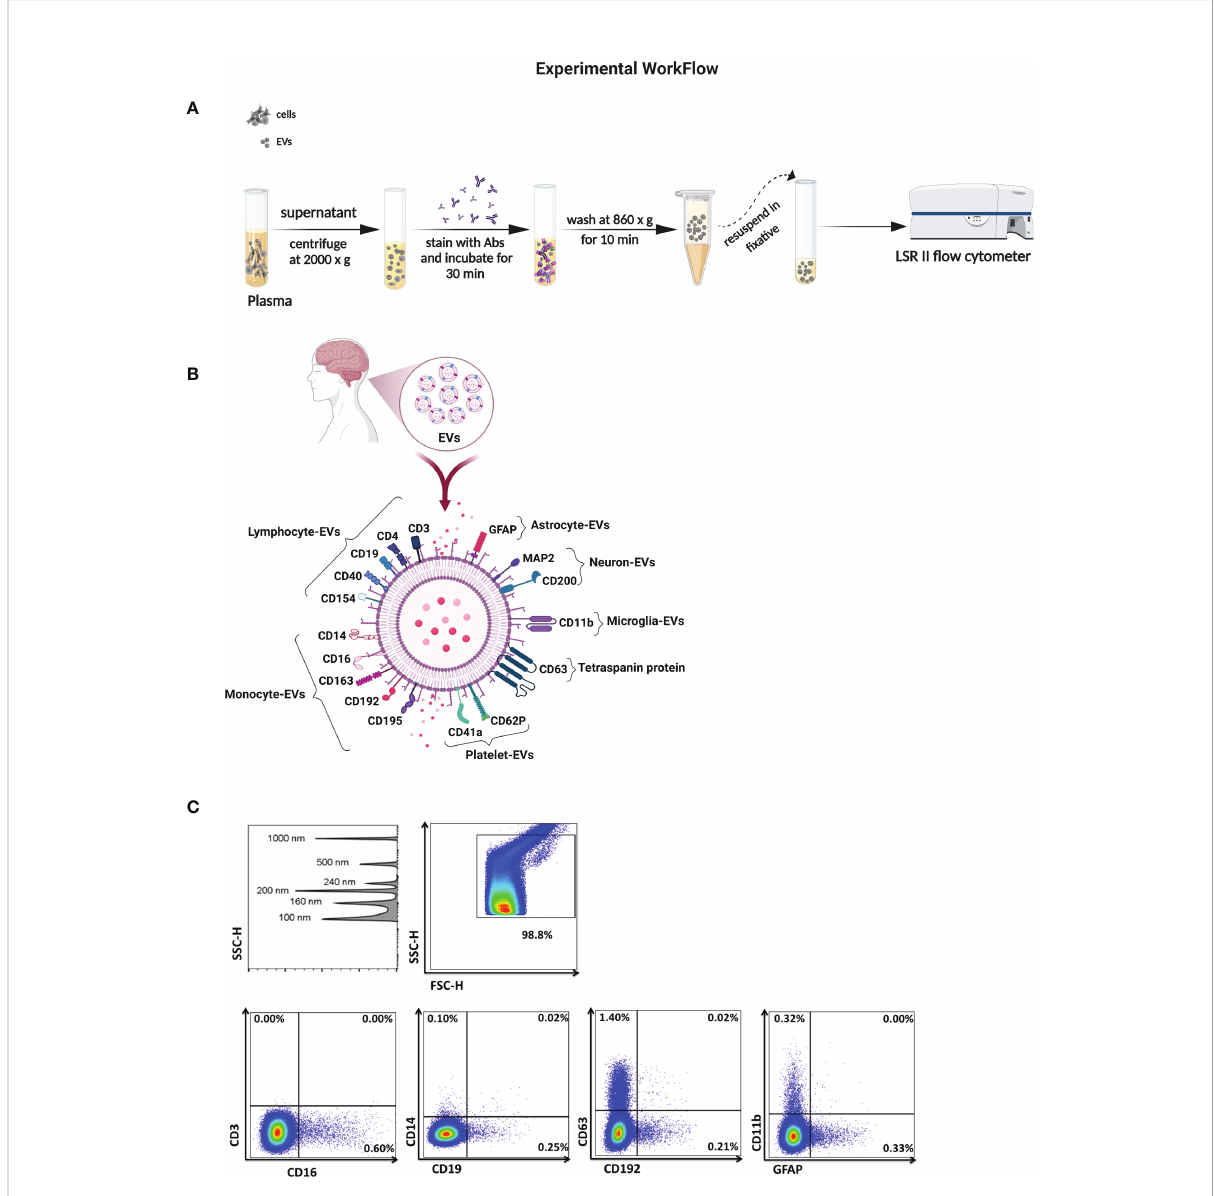
FIGURE 1 Characterization of EVs in biological samples. (A) Schematic of the method for isolation and analysis of EVs for their absolute count and cell of origin. (B) Illustration of surface markers on EVs linked to neuronal cells, lymphoid cells, and myleoid cells. (C) SSC height (SSC-H) dot plot shows sensitivity to detect beads sized 100 to 1000 nm in diameter. Representative plots of EV gated from the threshold to the 1000 nm gate based on SSC and sorted according to surface markers from their cell of